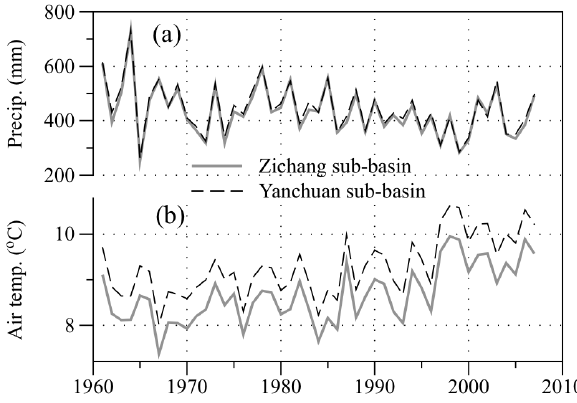
Figure 2. Annual changes of precipitation and air temperature for Zichang and Yanchuan sub-basins during the period of 1961–2007.